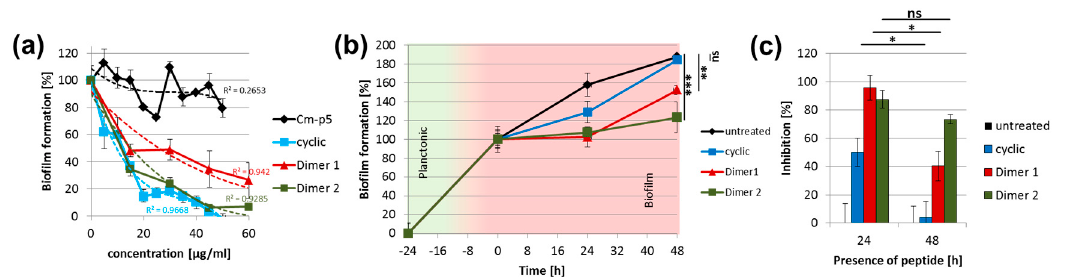
Figure 2. Biofilm inhibition by Cm-p5 derivatives. ( a ) Dose-dependent inhibition of C. auris de novo biofilm formation by cyclic Cm-p5, dimer 1 and dimer 2 quantified with crystal violet after 24 h.